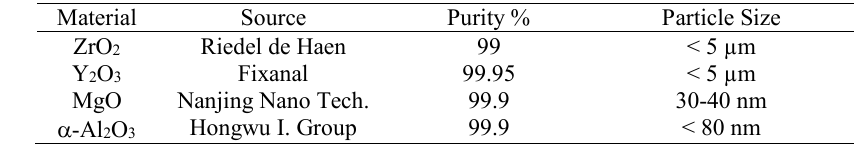
Table 1. Specifications of